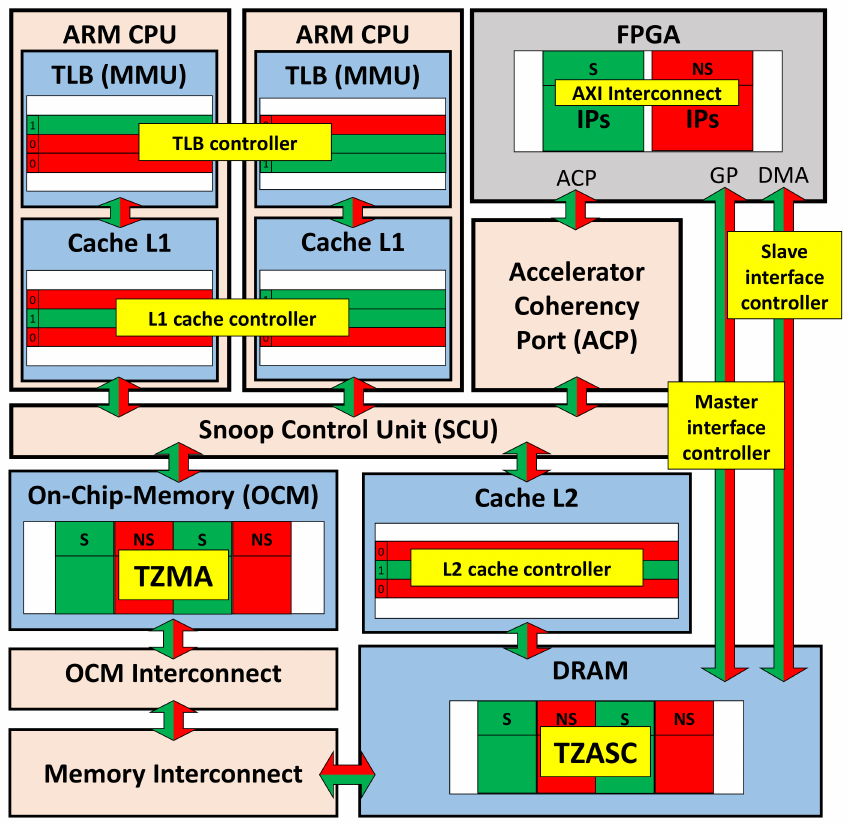
Figure 5. Memory hierarchy in the Xilinx Zynq-70110